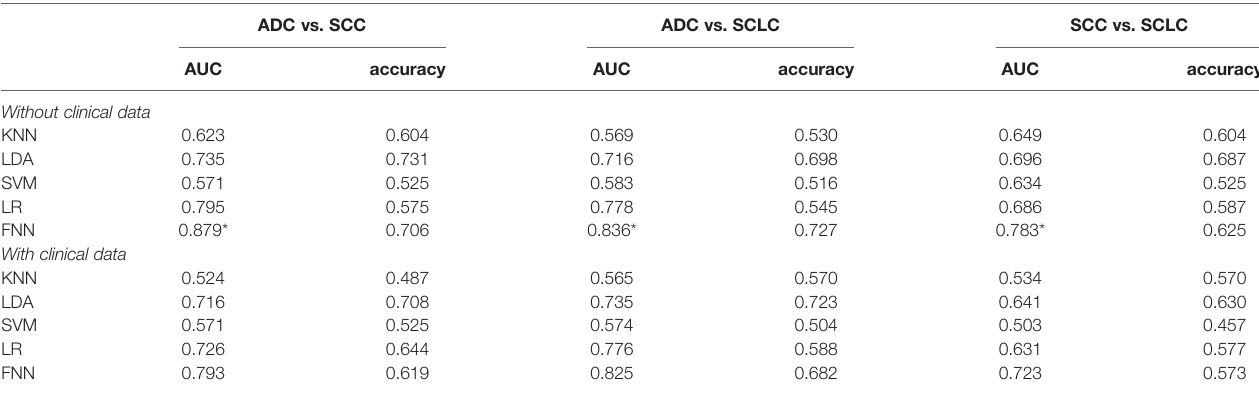
TABLE 2 | The performance of different models in three classi fi cation tasks.